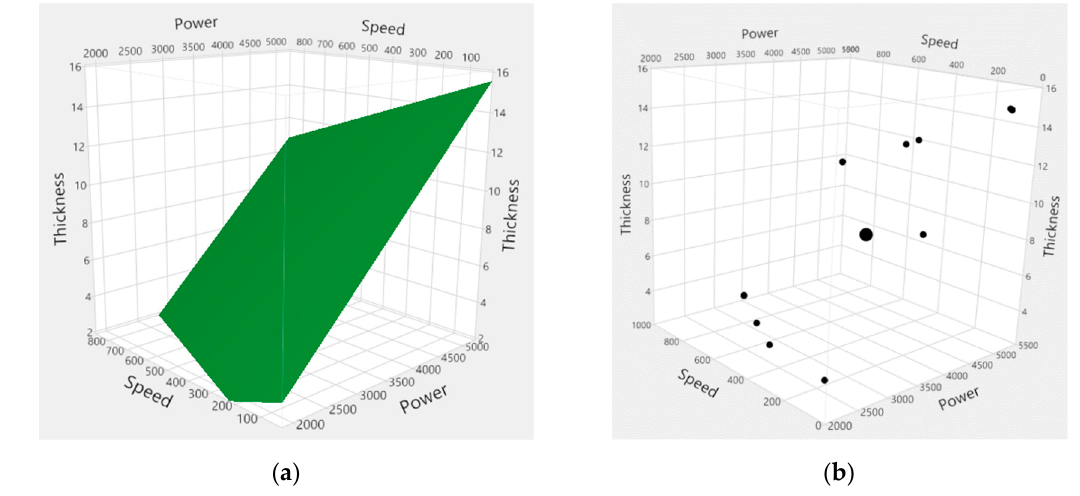
Figure4. Experimentalregionnoncubic: ( a )linearconstraintexpressedasaplane; ( b )the16experiments Figure 4. Experimental region noncubic: ( a ) linear constraint expressed as a plane; ( b ) the 16 distributed along the plane that defines the feasible experimental region. experiments distributed along the plane that defines the feasible experimental region.